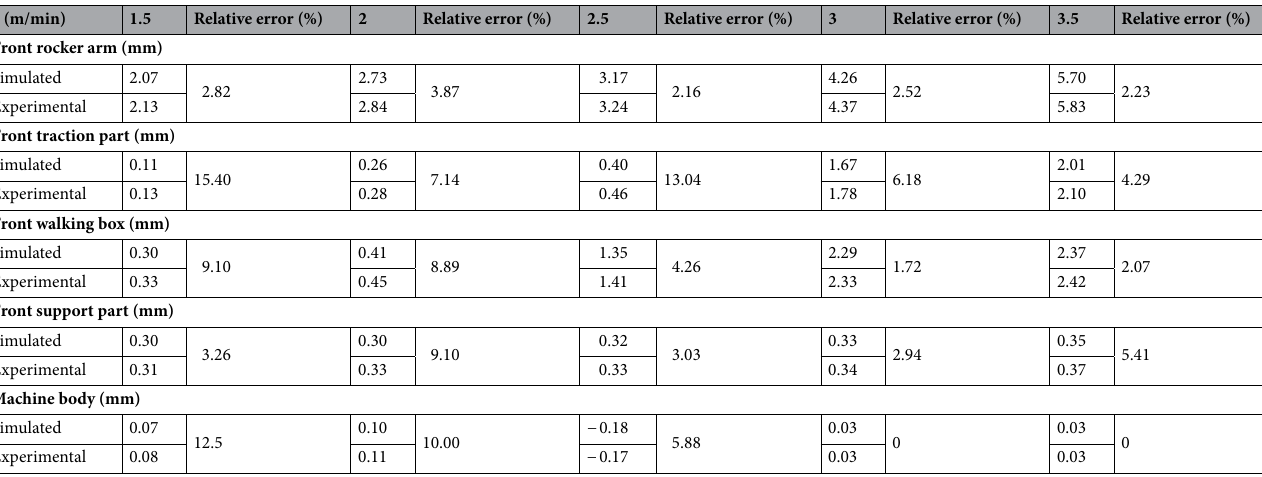
Table 8. Simulated and experimental vibration displacement values for parts of the shearer under different traction speeds.